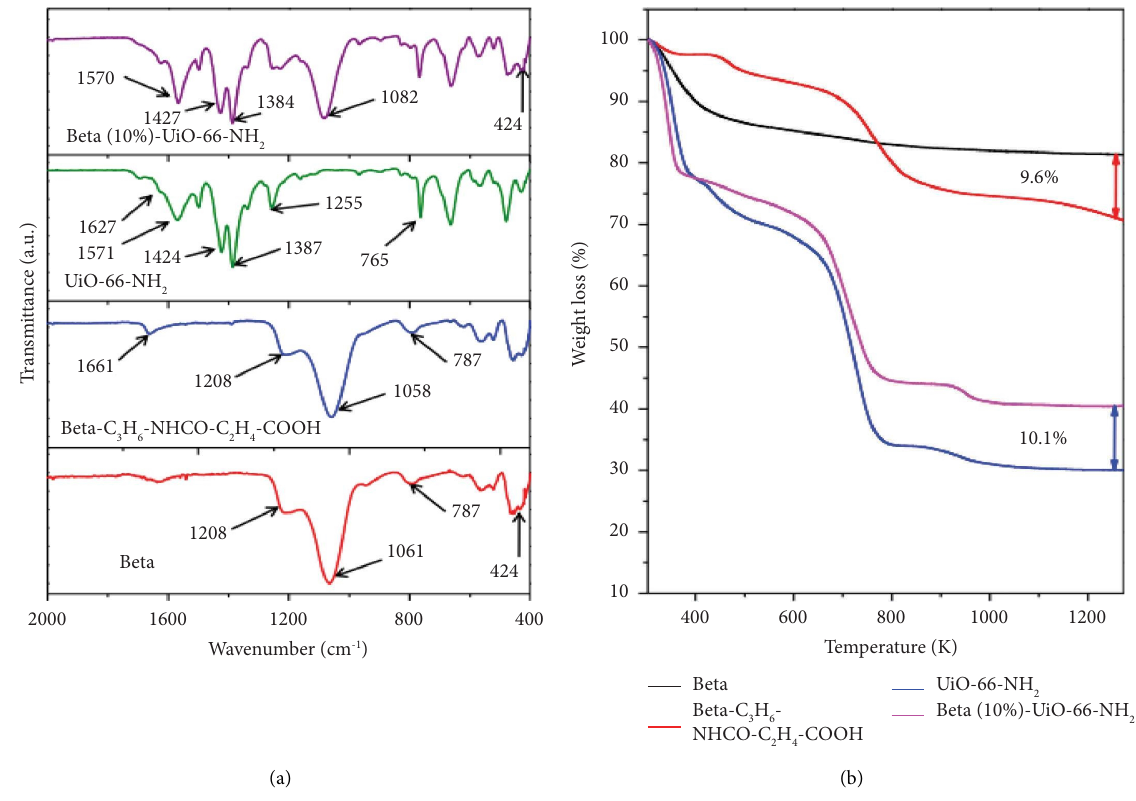
Figure 18: (a) FTIR spectra and (b) thermograms of parent and composite materials adopted from